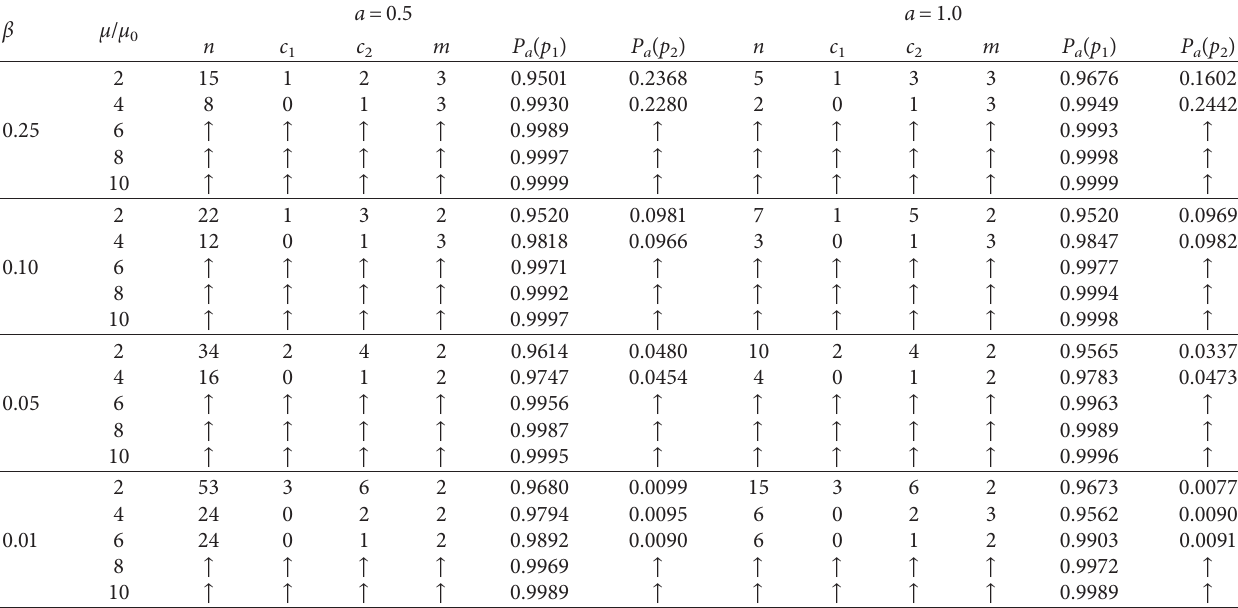
Table 6: Plan parameters of modified MDS sampling plan for Weibull distribution with δ �